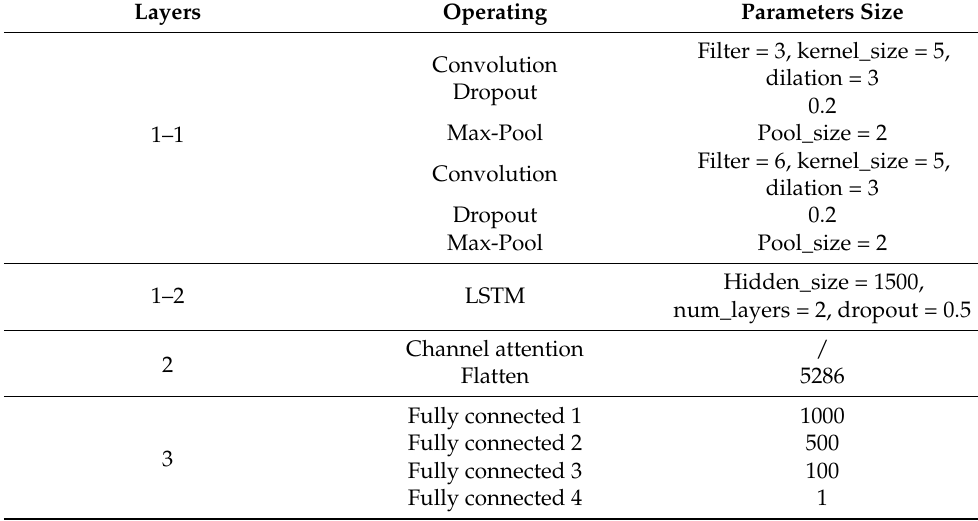
Table 2. Specific structure of the network